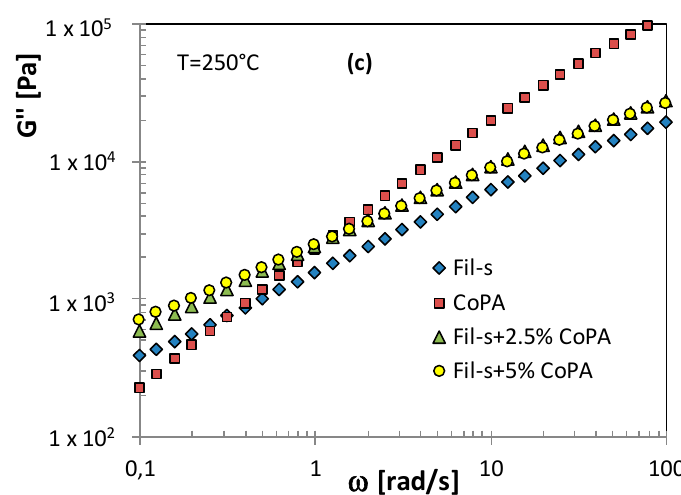
Figure 2. Comparison of the dynamic viscoelastic properties of Fil-s, the neat copolyamide, and their blends: ( a ) complex viscosity; ( b ) storage modulus; and ( c ) loss modulus.